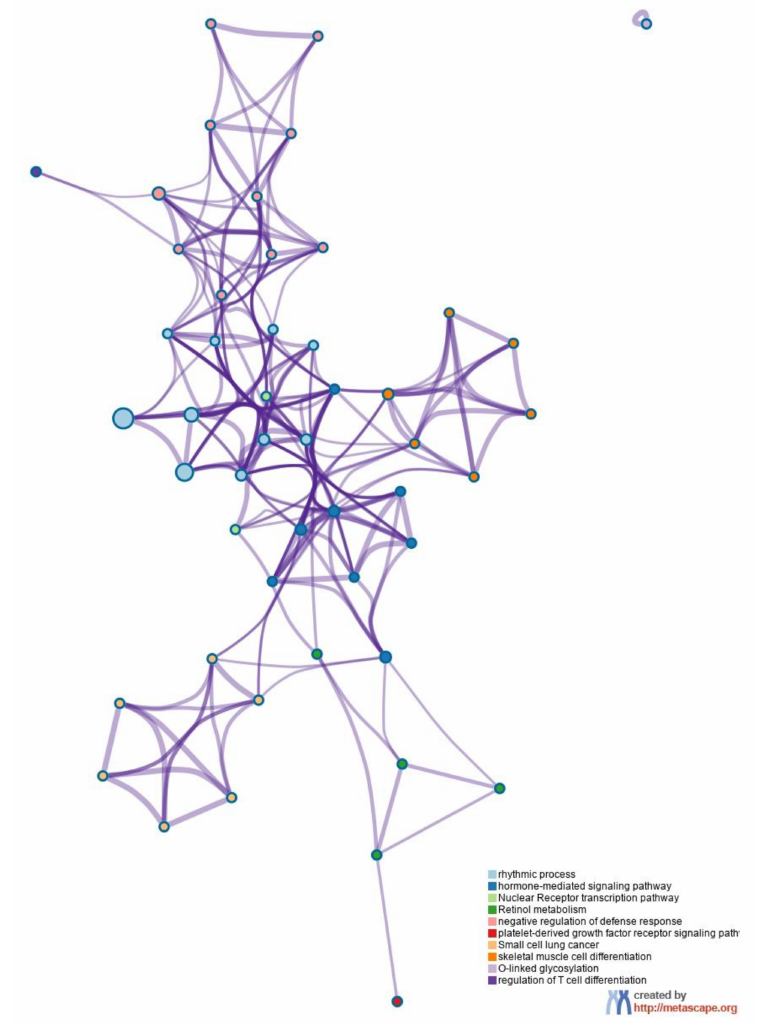
Figure 10. Network showing the interconnection of enriched terms. Clustered genes were typically close to each other and colored the same way when belonging to the same biological process, indicated by the legend in the bottom right corner. Edges linked similar terms, where thicker edges indicate higher similarity. The functional network shows genes according to their function and interaction. All 5% FDR-corrected DEGs (absolute FC ≥ 1.5, q-value < 0.05) following the exposure to 1 mg/kg bw /day of E171 from all timepoints were used to construct the network via